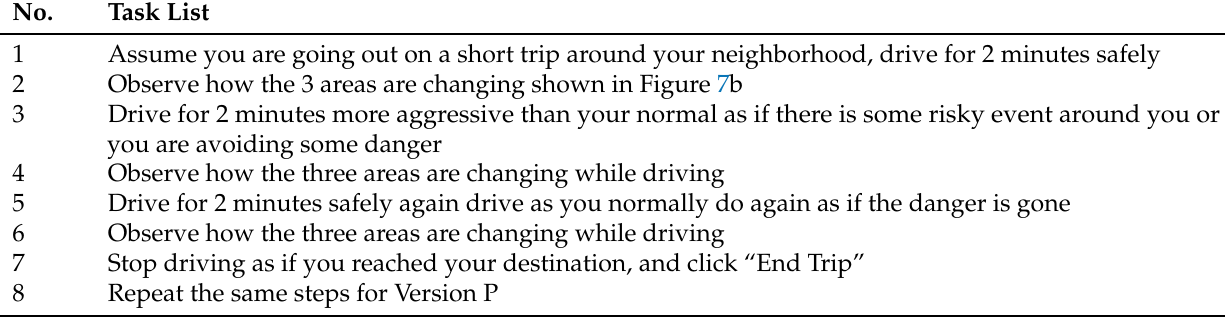
Table 6. User study task